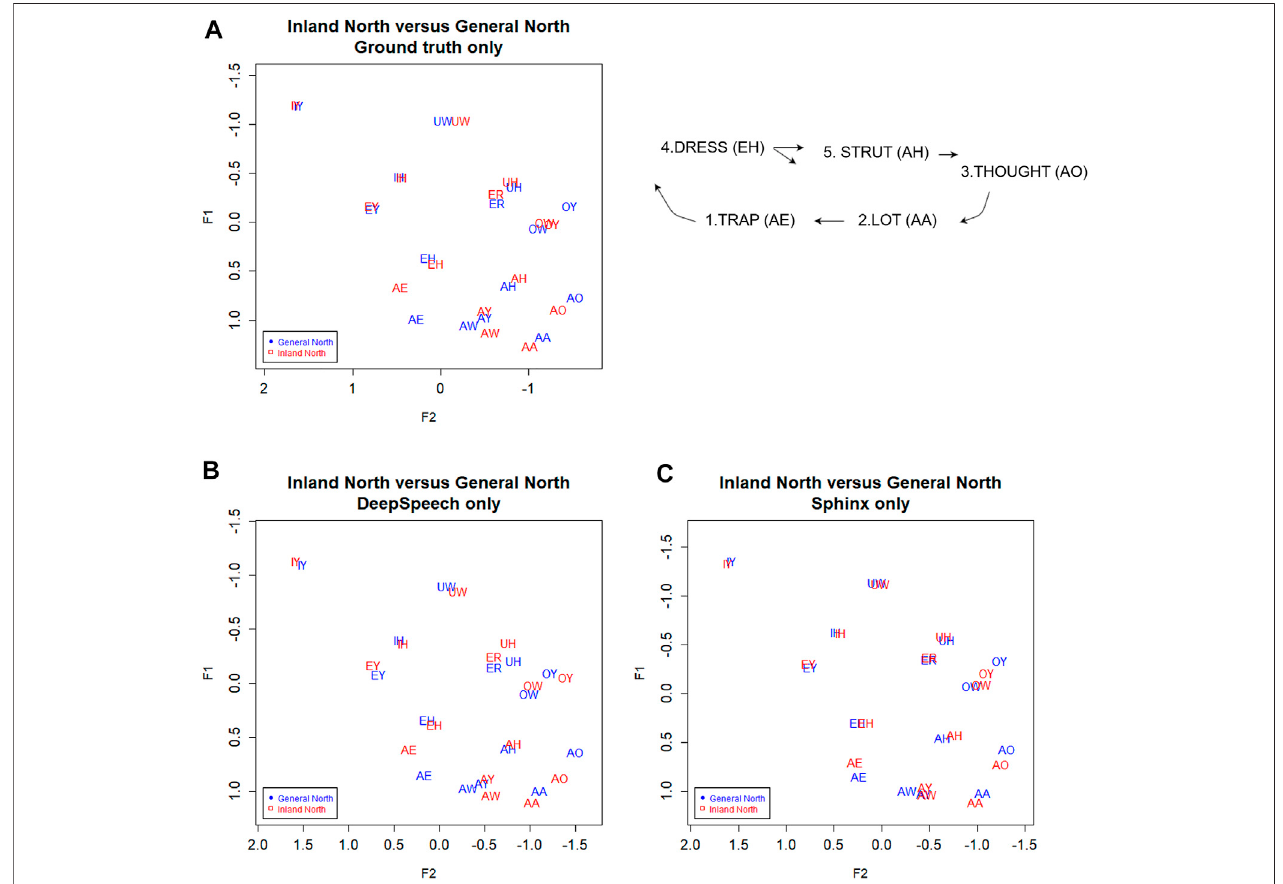
FIGURE8| InlandNorth(red)andGeneralNorthernspeakers(blue)inthe (A) groundtruthtranscription,andtranscribedautomaticallyby (C) DeepSpeechand (D) Sphinx. Speaker vowel means for 225 speakers, 21,200 vowel tokens. Plotted in Lobanov-normalized units. (B) Schematic of the primary movements of the Northern Cities Vowel Chain Shift (adapted from Nesbitt,